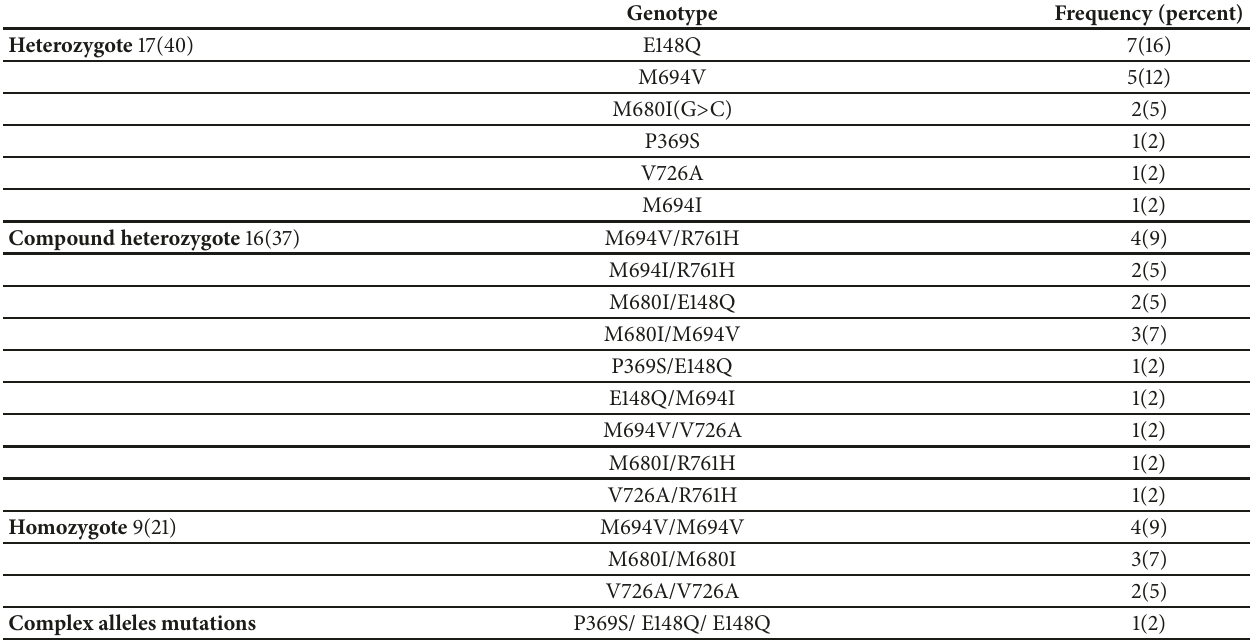
Table 1: Frequency of different genotype in Familial Mediterranean Fever patients.